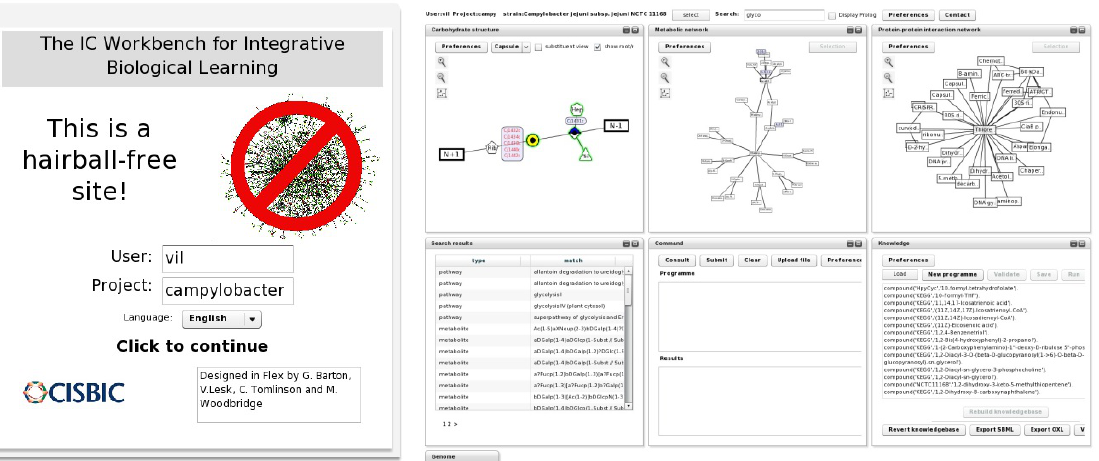
Figure 2 WIBL splash screen and